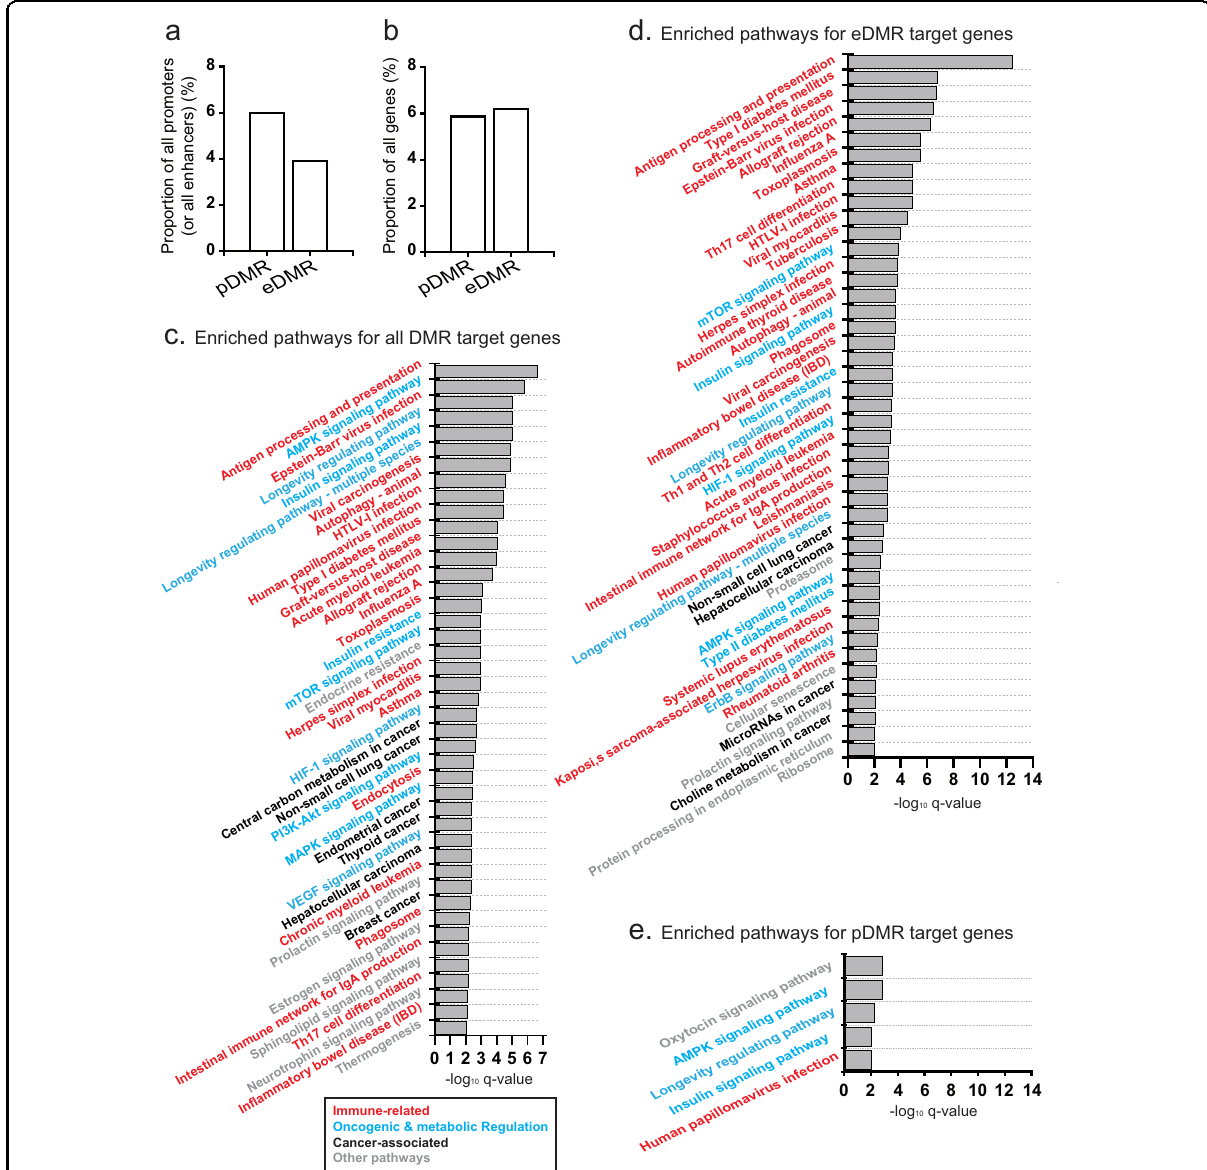
Fig. 2 KEGG pathways enriched for DMR target genes. a Proportion of all promoters and enhancers that overlap with DMRs (i.e., pDMRs and eDMRs, respectively). b Proportion of all genes targeted by pDMRs and eDMRs. c – e Signi fi cantly enriched ( q value < 0.01) KEGG pathways for all DMR target genes c for eDMR target genes d and for pDMR target genes e . Immune-related, oncogenic, and metabolic-regulation KEGG pathways; cancer- associated and other pathways are marked by different color